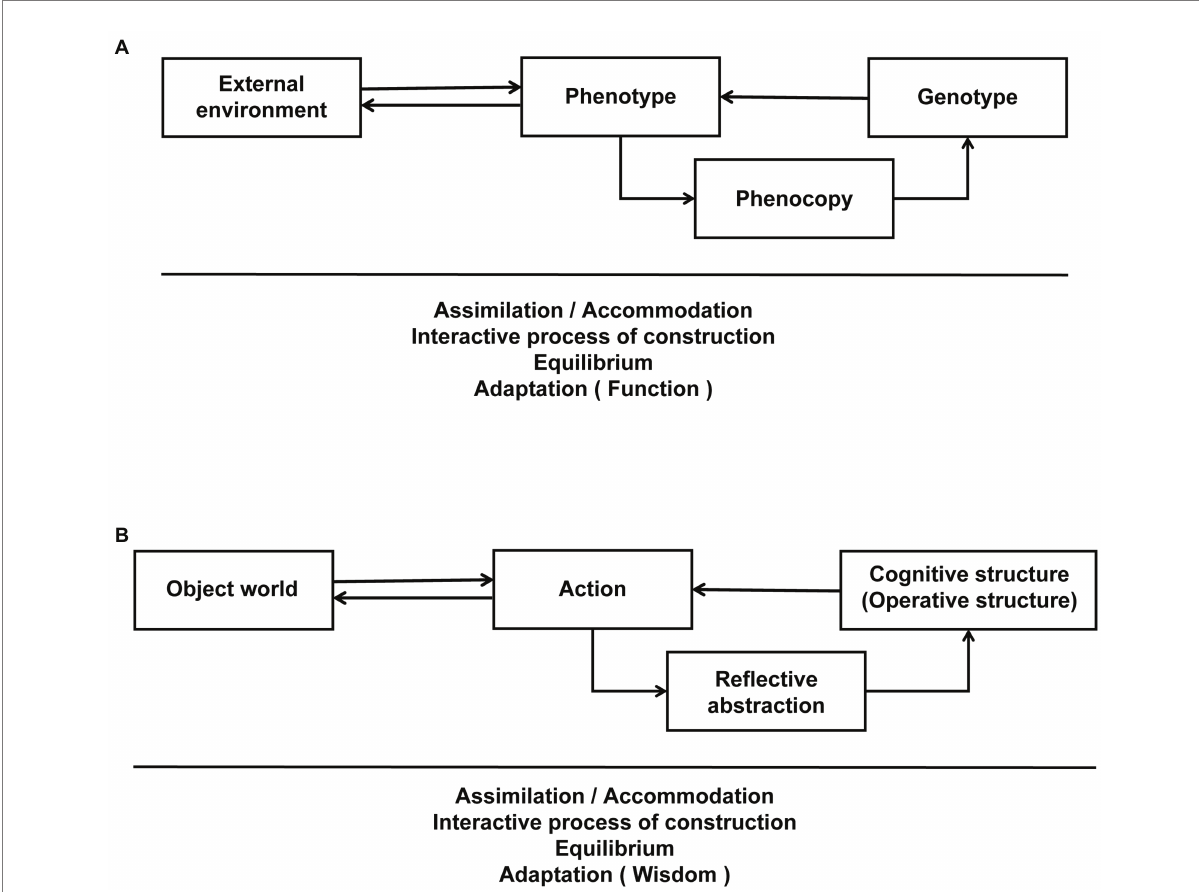
FIGURE 1 The process of interactive construction between the cognitive/operative structure and the object world (adapted and reproduced from Jiang and Li (2020) with permission). (A) The process of interactive construction of an organism with the external environment. The active interaction between the internal mechanisms of the organism and the external environment constructs the phenotype. There is a two-way interaction between the phenotype and the external environment as shown by the double arrows. Whereas the genotype determines the phenotype, the phenotype can feedback to the genotype through the process of phenocopy as shown by the single arrow. The effect of internal mechanisms on the external environment throughout the process is called assimilation. The active regulation of internal mechanisms is known as accommodation. Assimilation and accommodation balance the internal and external aspects of the organism to achieve an adaptive equilibrium, whose steady state is called adaptation or function. (B) The process of interactive construction of the cognitive/operative structure and the object world. The active interaction between the cognitive/operative structure and the object world constructs the subject’s action (behavior). The interaction between the subject’s action and the object world is shown by the double arrows. The cognitive/operative structure determines the subject’s action but receives feedback from the outcome of the action in interaction with the object world via reflective abstraction, as shown by the single arrow. Similarly, the effect of internal mechanisms on the external environment is referred to as assimilation, while the active regulation of the internal mechanisms is referred to as accommodation. Assimilation and accommodation allow the subject to reach equilibrium with the environment. When the environment changes and the subject is no longer able to adapt to the environment conditions, a “de-equilibration” occurs, and the need for re-equilibrium becomes a motivation for the subject to make behavioral adjustments. The individual responds to the changes in the external world through actions, and the abstracted reflection on the outcome of the new action leads to a refreshed internal cognitive/operative structure and a higher level of rebalancing. At this point, cognitive abilities also develop to a higher level. The subject is able to adapt to the environment and gain wisdom. Note that the developmental norm of the cognitive/operative structure is called a